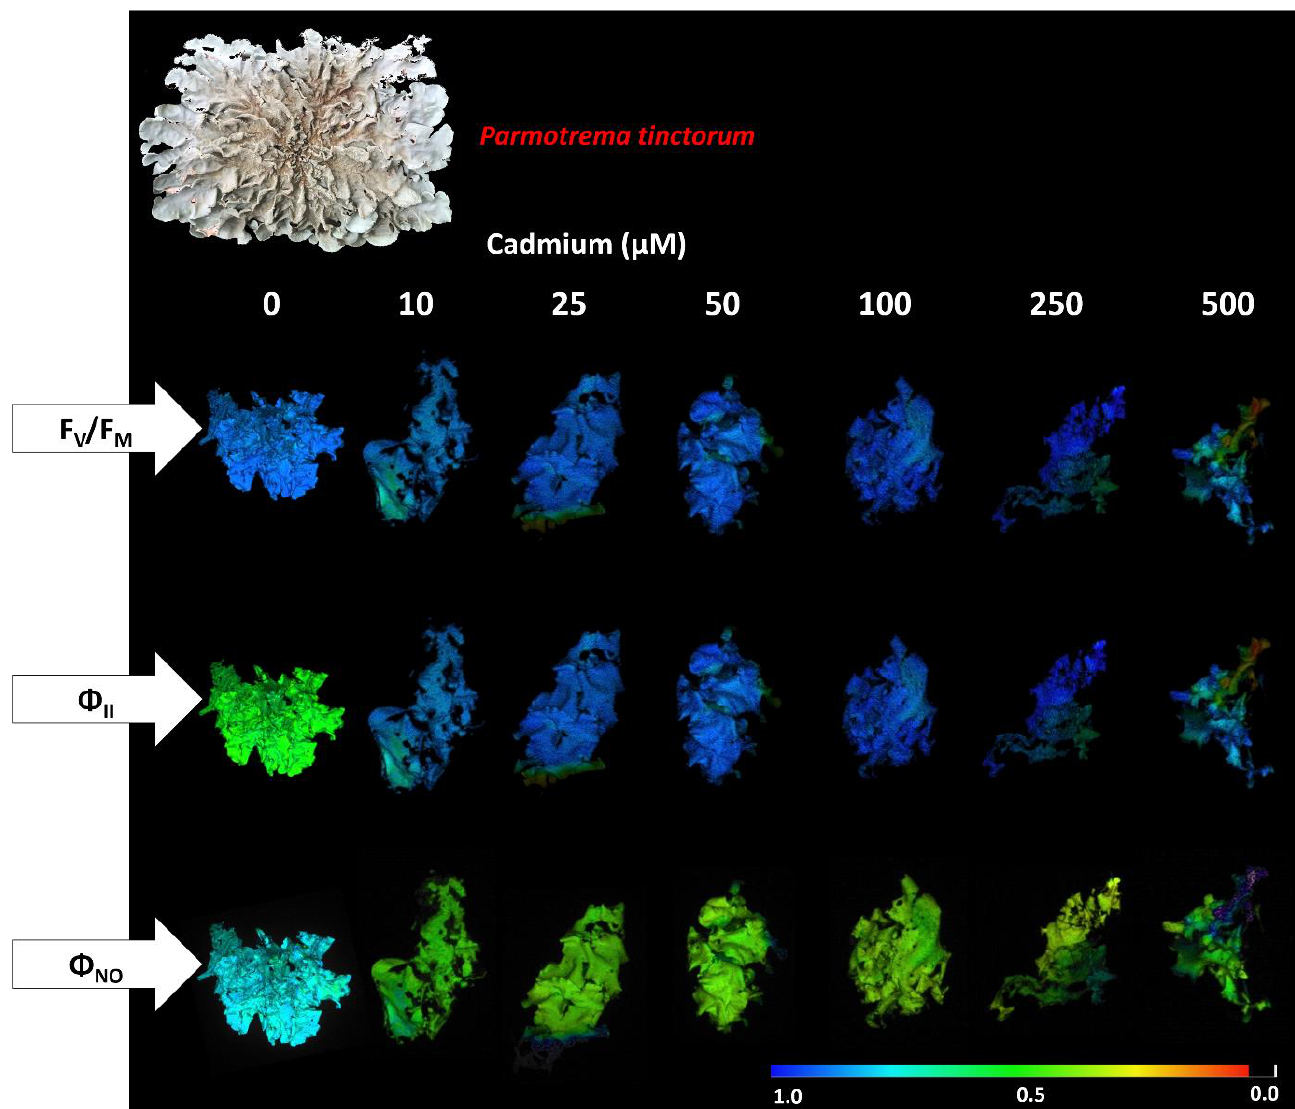
Figure 8. Chlorophyll a fluorescence parameters: FV/FM (maximum quantum efficiency of PSII photochemistry), ΦII (effective quantum yield of photochemical energy conversion in PSII), and ΦNO (quantum yield of unregulated energy dissipation) observed for the photobiont of the lichen Parmotrema tinctorum subjected to different concentrations of Cd (0, 10, 25, 50, 100, 250, and 500 µM).